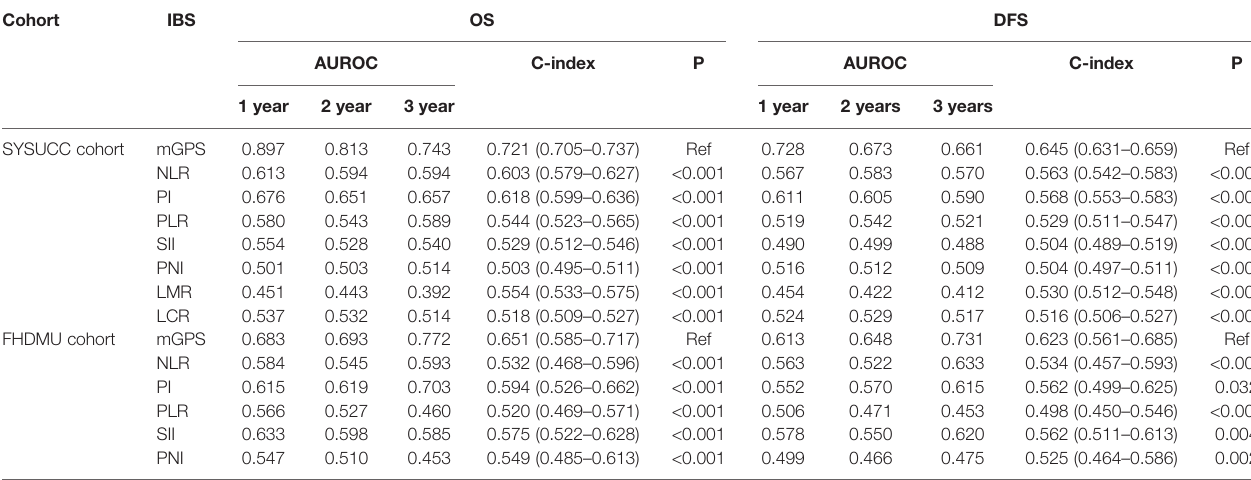
AUROC, area under the ROC curves. Other abbreviations as in Table 3